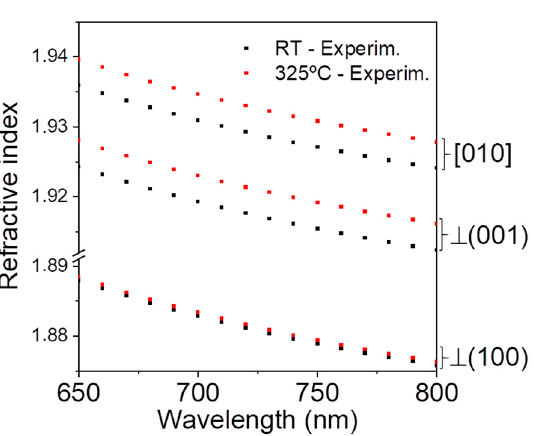
Figure 2. Refractive index values for the three axes at 25 °C (298 K) and 325 °C (598 K) obtained from ellipsometry data from Ga 2 O 3 bulk crystal.